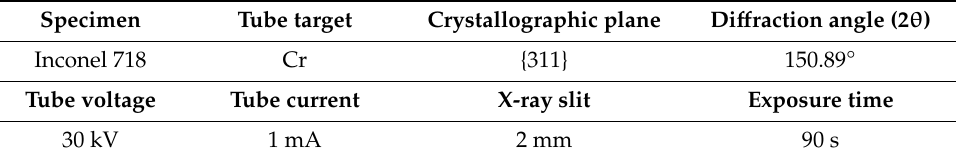
Table 4. X-ray di ff raction parameters of residual stress